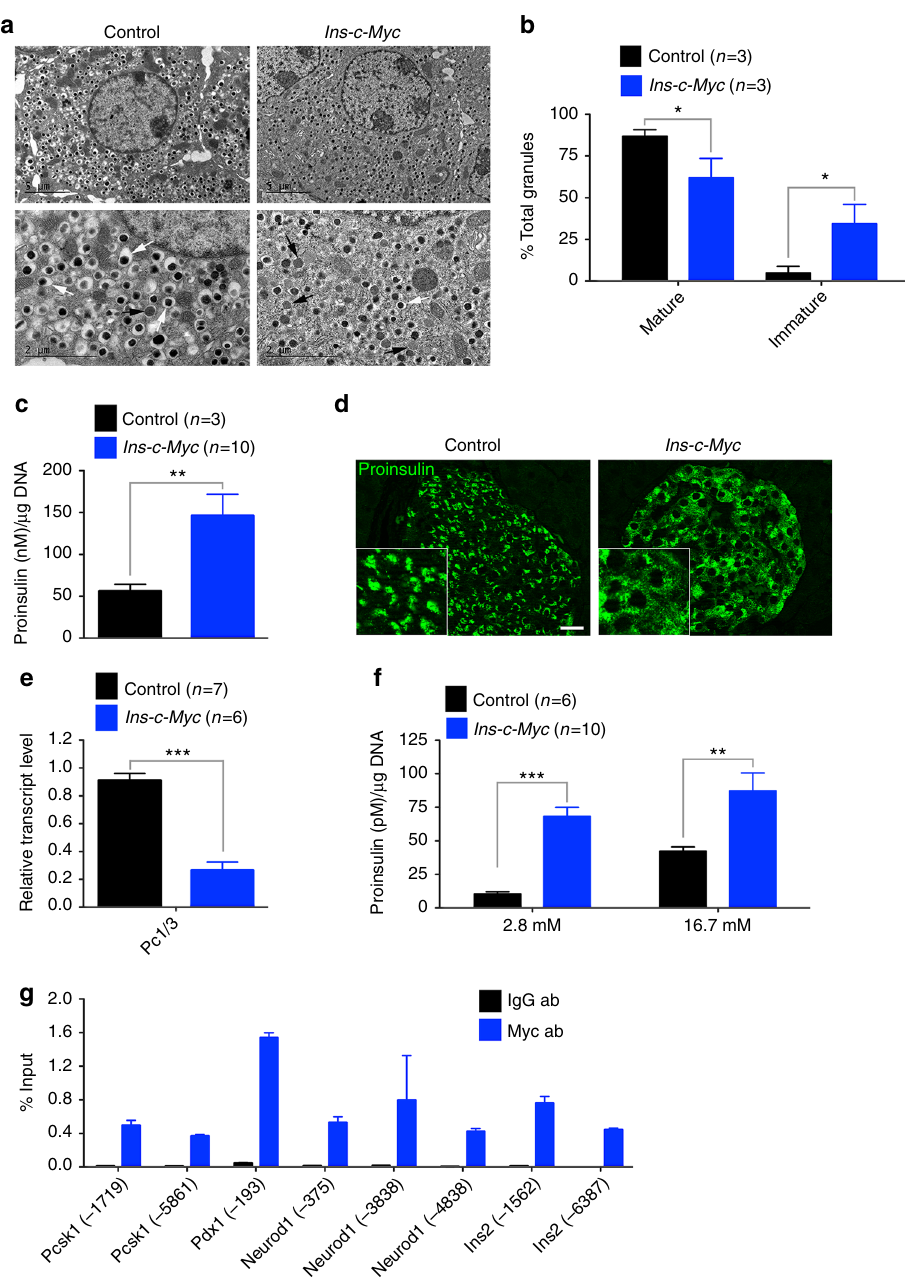
Fig. 4 Accumulation of features of immaturity in c-Myc-expressing β cells. a Electron microscopy shows accumulation of classical mature insulin granules with a dark core surrounded by a clear halo (white arrows) in control islets. Immature granules have a less dense core and poorly de fi ned halo (black arrows). Top panel, scale bar: 5 μ m, lower panel, scale bar: 2 μ m. b Quanti fi cation of mature and immature granules in control (black bars, n = 3) and transgenic (red bars, n = 3) samples. Error bars indicate ± SD. * p < 0.05, Student ’ s t test. c Total proinsulin content in islets isolated from control (black bar, n = 6) and transgenic (red bar, n = 10) animals. Error bars indicate ± SEM. ** p < 0.005, Student ’ s t test. d Immunostaining for proinsulin reveals a diffuse distribution of proinsulin-containing vesicles in the transgenic islets. Scale bar: 20 μ m. e Quantitative PCR to determine the level of Pc1/3 in transgenic islets (red bar, n = 6) as compared to control islets (black bar, n = 7). Error bars indicate ± SD. *** p < 0.0005, Student ’ s t test. f Proinsulin secretion from transgenic (red bars, n = 10) versus control (black bars, n = 6) islets under basal (2.8mM) and stimulatory (16.7mM) glucose conditions. Error bars indicate ± SEM. ** p < 0.005, *** p < 0.0005, Student ’ s t test. g Chromatin immunoprecipitation analysis to assess the recruitment of Myc to upstream canonical binding sites in the genes shown on Ins-c-Myc islets ( n = 2). IgG was used as the negative control. Data are shown as percent of input. Error bars indicate ± processes important for cell growth and proliferation, including Myc-expressing β cells mimic gene expression pro fi les of upregulation of ribosomal proteins (Fig. 5b and Supplementary neonatal, immature β cells. Fig. 5g). As expected, gene set enrichment analysis (GSEA) revealed an enrichment of Myc targets in transgenic islets c-Myc causes a shift to a state poised for proliferation . Gene (Fig. 5c). Several genes identi fi ed as Myc targets were involved in ontology (GO) analysis of c-Myc islets revealed changes in